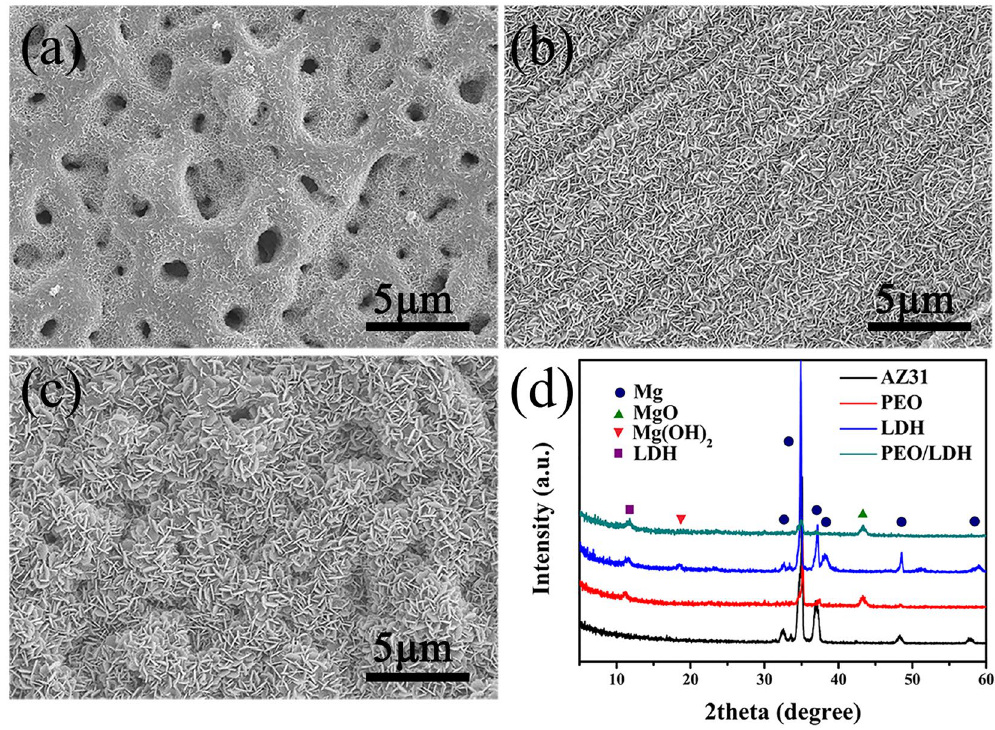
Figure 2. Surface morphology of PEO ( a ), LDH ( b ) and PEO/LDH ( c ); XRD patterns of all samples ( d